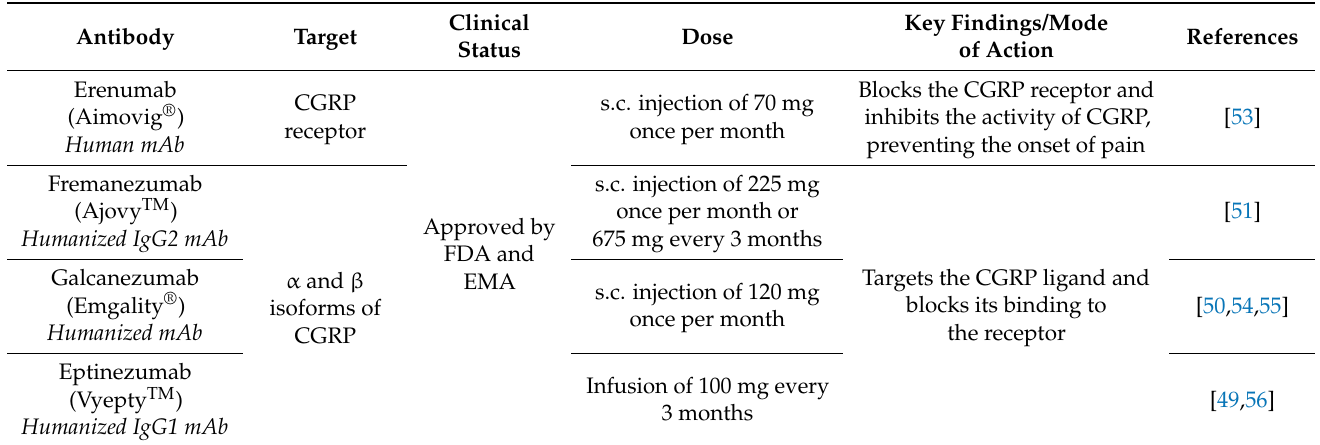
Table 2. Approved therapeutic antibodies for